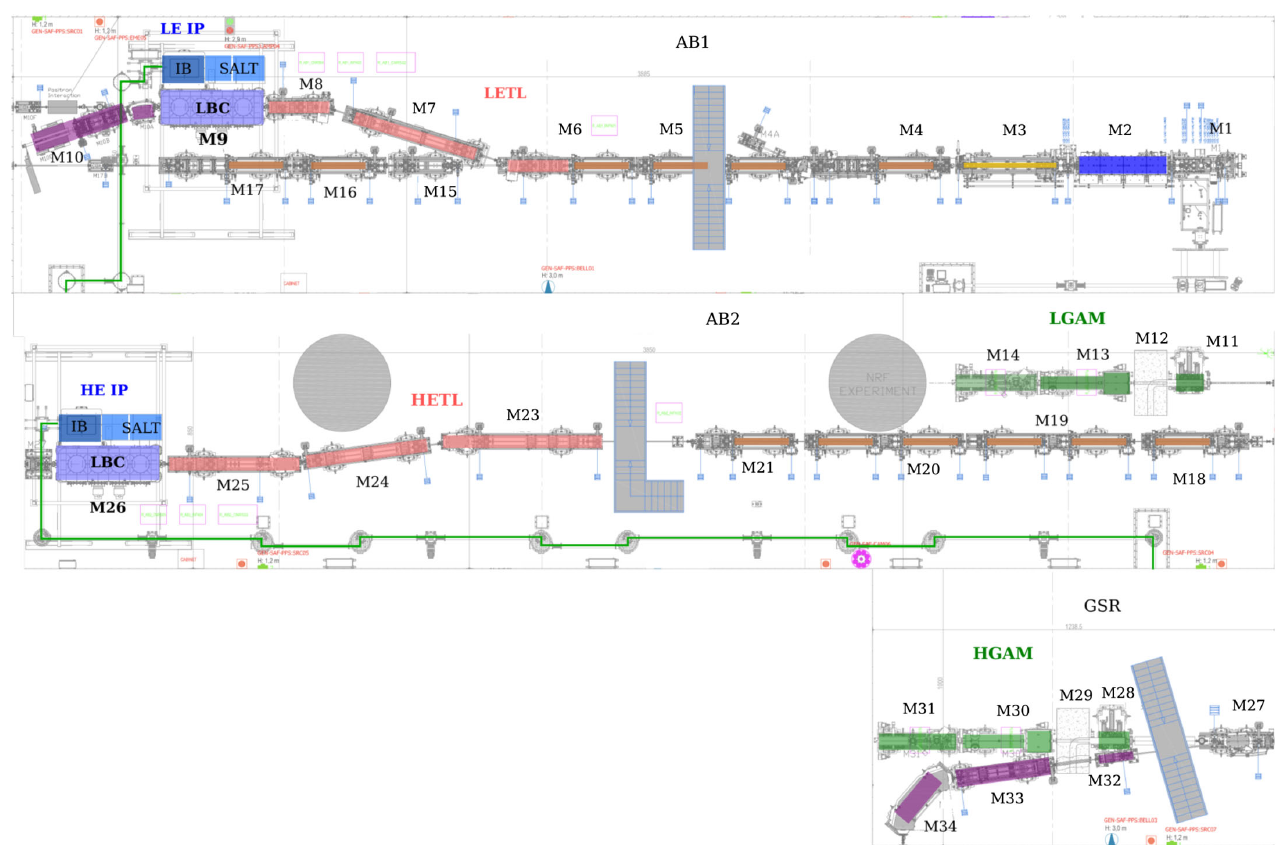
FIG. 1. Folded Top view drawing of the Gamma Beam source. The scale in width is 39 m. The machine is divided in 3 rooms: Accelerator Bay 1 (AB1), Accelerator Bay 2 (AB2) and Gamma Source Region (GSR). The green line represent the high power laser beam path to each interaction point region. M1-M3: S-band photo-injector; M4-M6: first C-band linac; M7-M8: Low energy transport line (LETL), M9: low energy interaction point (LE IP); M10: Low energy beam dump; M11-M14: Low energy gamma beam line with M11 the collimator; M15-M21: second C-band linac; M23-M25: high energy transport line (HETL); M26: high energy interaction point (HE IP); M28-M31: high energy gamma beam line (HGAM) with M28 the collimator; M32-M34: high energy beam dump (partially